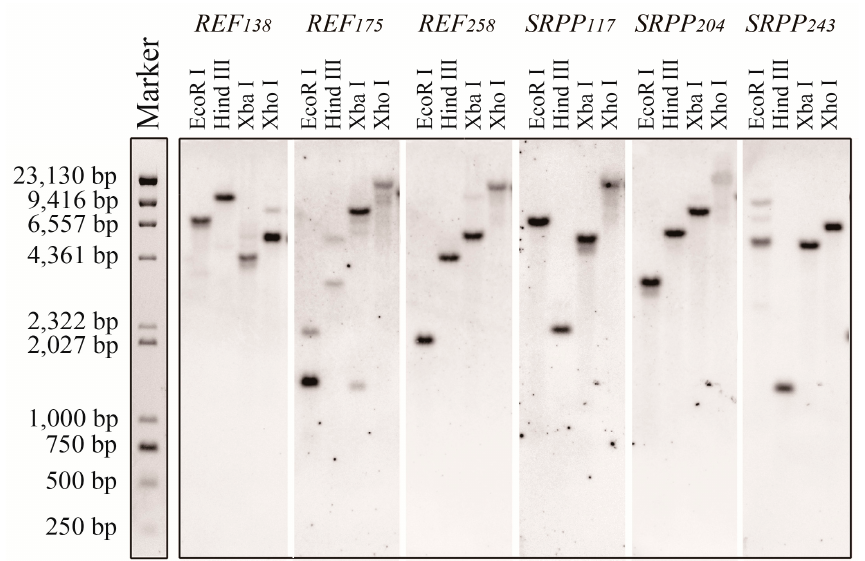
Figure 2. Southern blot of REFs and SRPPs in genomic DNA isolated from rubber tree clone RY 7-33-97. Endonucleases Eco R I, Hind III, Xba I, and Xho I were used for digestion of genomic DNA. DNA molecular mass markers are shown on the left.